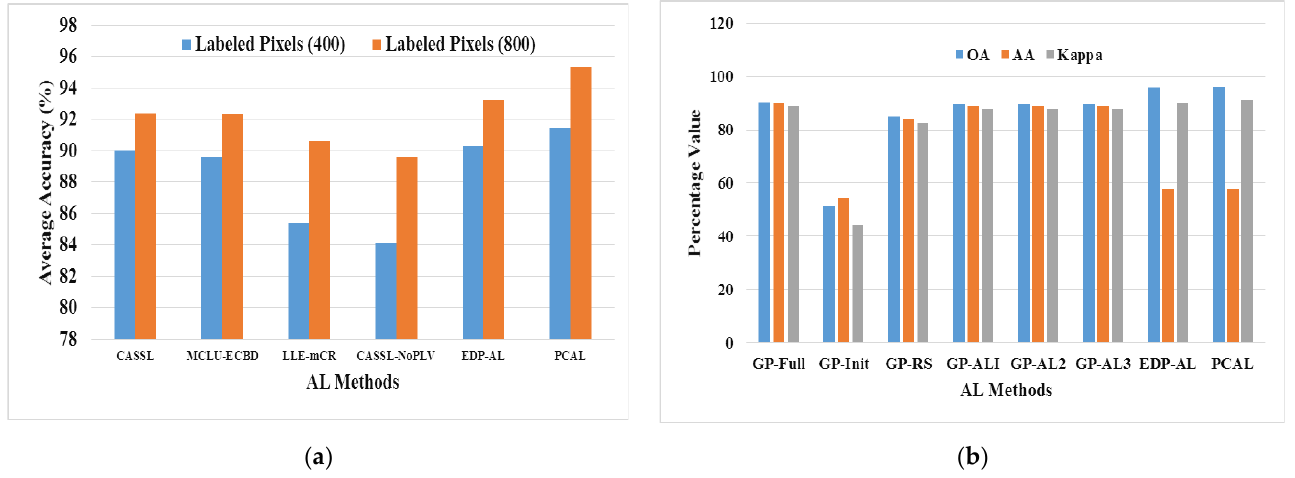
Figure 13. ( a ) Average accuracy analysis for Pavia University labeled samples (400 and 800) and ( b ) overall and average accuracy analysis for Indian